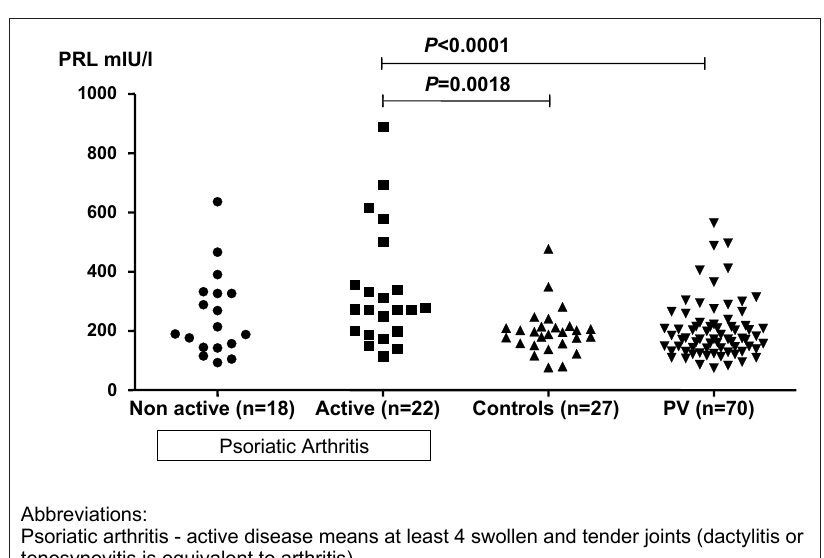
Fig. 3. Differences in serum prolactin (PRL) levels in Psoriatic Arthritis patients with and without active disease, Psoriasis Vulgaris (PV) and Healthy Individuals